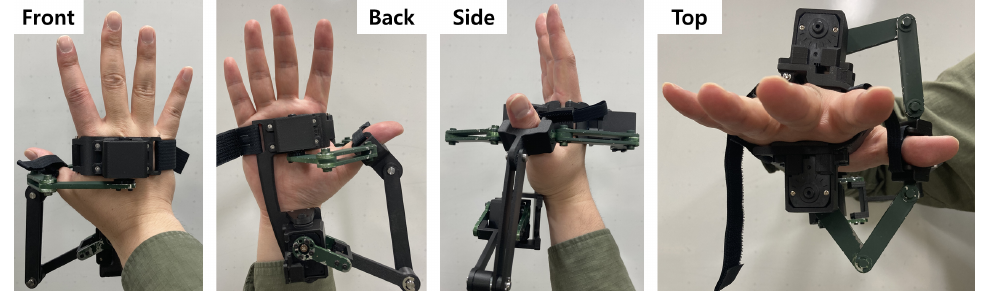
Figure 15. Manufactured final design of prototype.